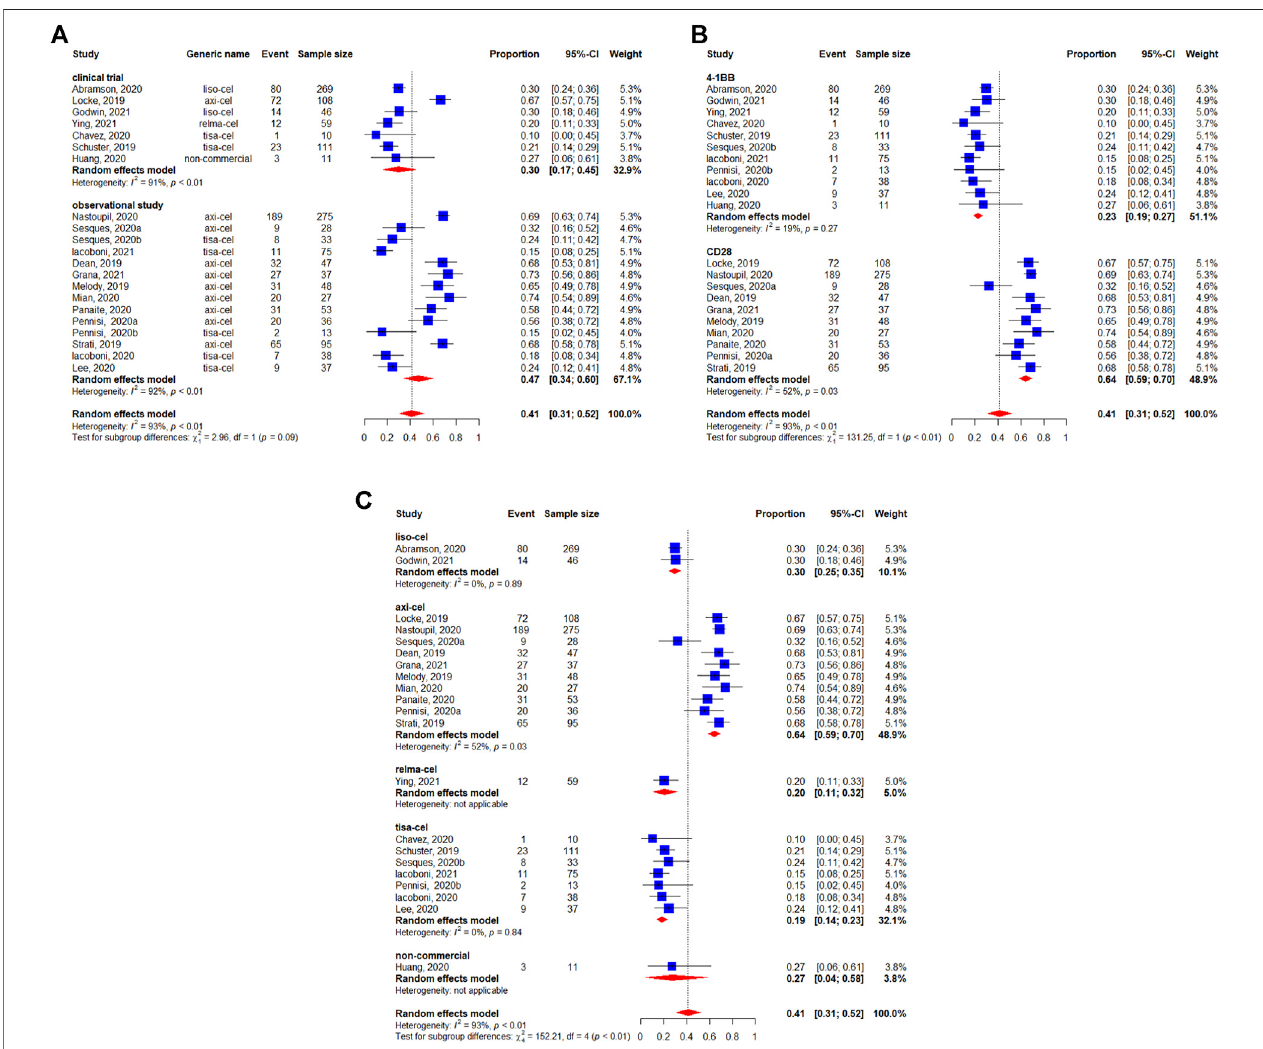
FIGURE8| Any-gradeneurotoxicityofpatientswithdiffuselargeB-celllymphoma(DLBCL)treatedwithchimericantigenreceptorTcells(CAR-Ts)accordingto (A) study design, (B) the costimulatory domain, and (C) type of chimeric antigen receptor T cells (CAR-T).